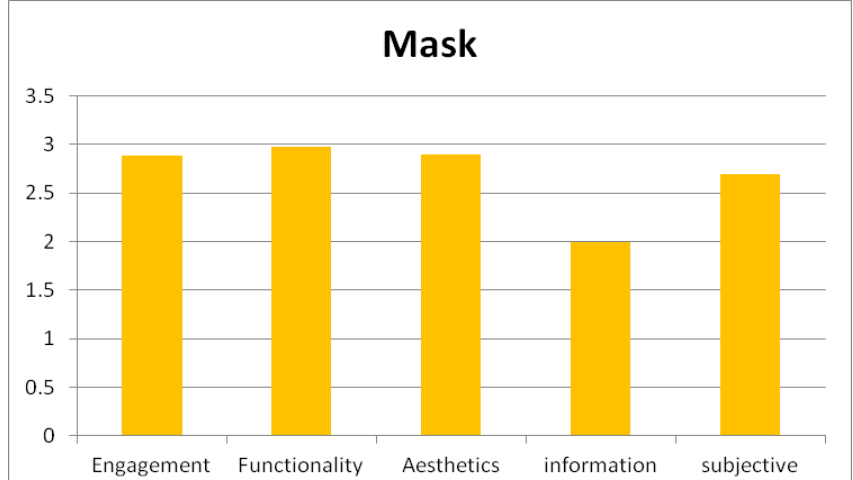
Fig 3. The evaluation of indicators in Mask according to MARS subscales